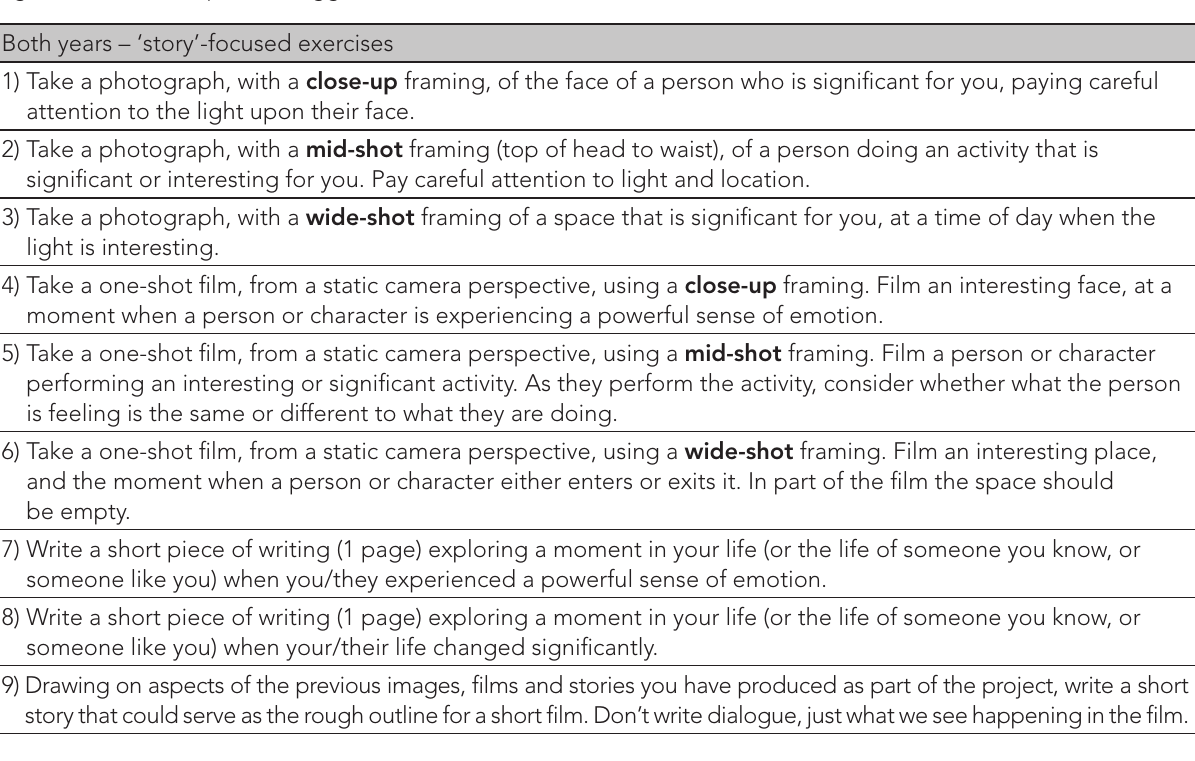
Table 1c. Both years – ‘story’-focused exercises